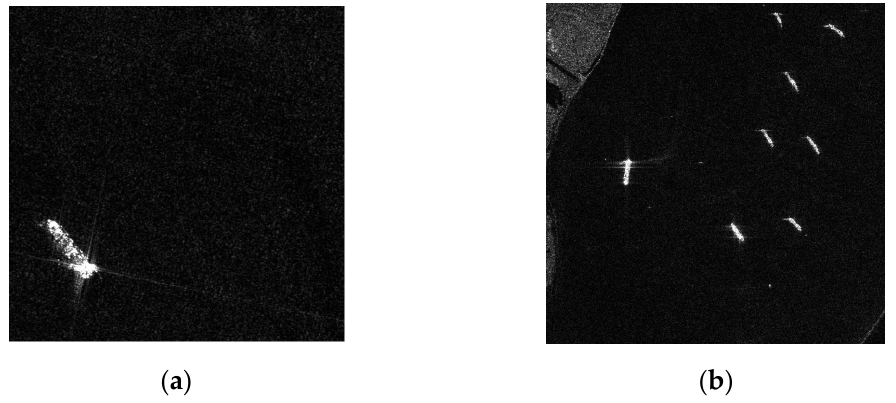
Figure 1. ( a , b ) A few images of 800 × 800 pixels from the HRSID dataset. Table 1. Information of the images from the HRSID